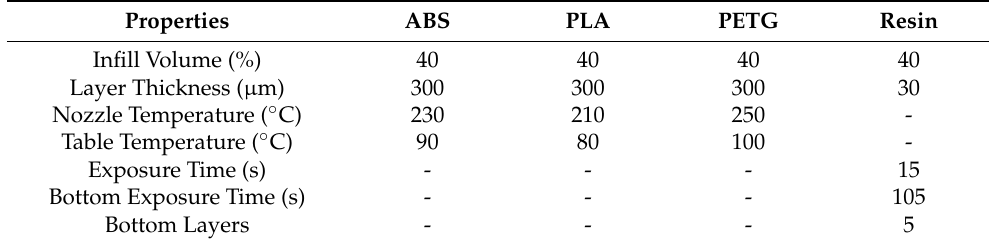
Table 1. Printing parameters of materials used for fabrication in FDM and SLA 3D printers.